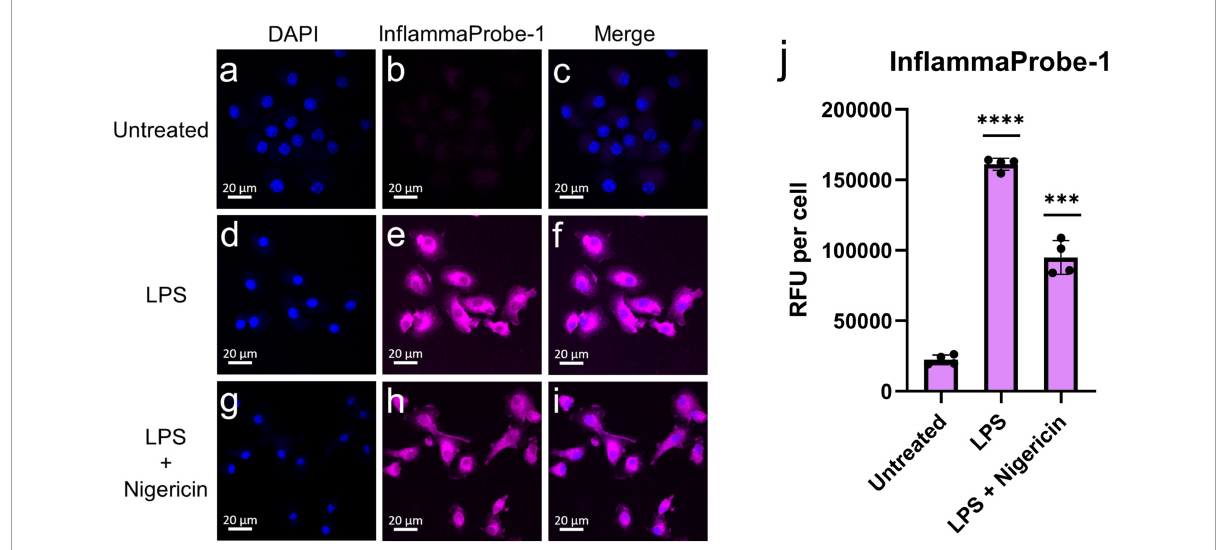
FIGURE3 In vitro imaging of NLRP3 in bone marrow-derived macrophages (BMDMs) using InflammaProbe-1. (a–c) Untreated BMDMs, (d–f) LPS-primed BMDMs, and (g–i) LPS-primed and nigericin-stimulated BMDMs that were treated with 10 µ M InflammaProbe-1, fixed on microscope slides, and imaged using confocal fluorescence microscopy. (j) Quantification of InflammaProbe-1 RFUs per cell of confocal microscopy images. Relative to the untreated control cells, those that were treated with LPS alone or with LPS and nigericin displayed significantly brighter InflammaProbe-1-dependent fluorescence ( p < 0.0001 and p < 0.001, respectively). These results indicate that InflammaProbe-1 selectively stains macrophages that have been induced to express NLRP3. These data are representative of four replicates from each experimental group. Statistical analysis by unpaired t -tests with Welch’s corrections; ∗∗∗ p < 0.001 and ∗∗∗∗ p < 0.0001 relative to the untreated